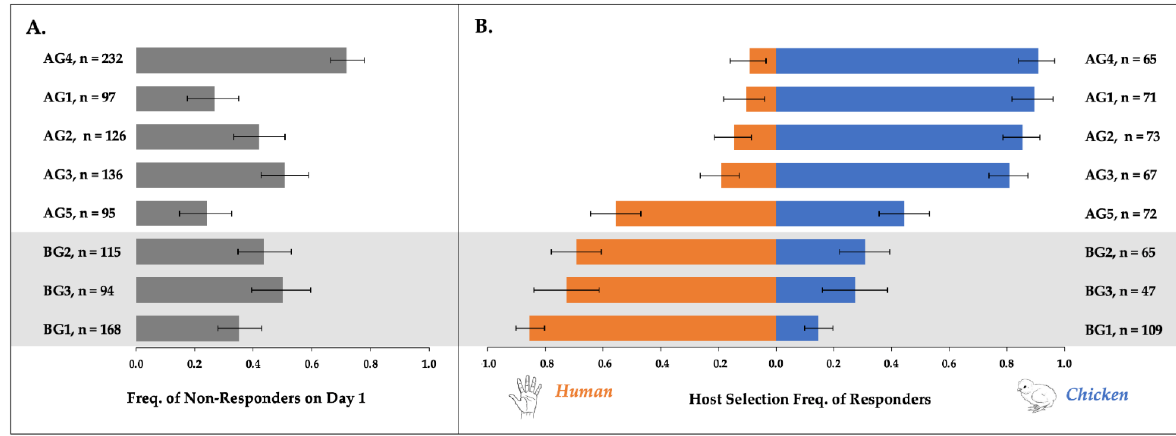
Figure 1. Observed response rates with bootstrapped 95% confidence intervals (n = 5000) to human vs. chicken host for five above-ground and three below-ground populations of Culex pipiens . Panel ( A ) shows the frequency of non-responders on Day 1, and n = total number of mosquitoes assessed (d.f. = 7; χ2 = 26.8; p < 0.0004). Panel ( B ) shows the frequency with which Day 1 responders (n) selected either a human or avian host in multi- day tests (d.f. = 7; χ2 = 143.46; p < 0.0001).